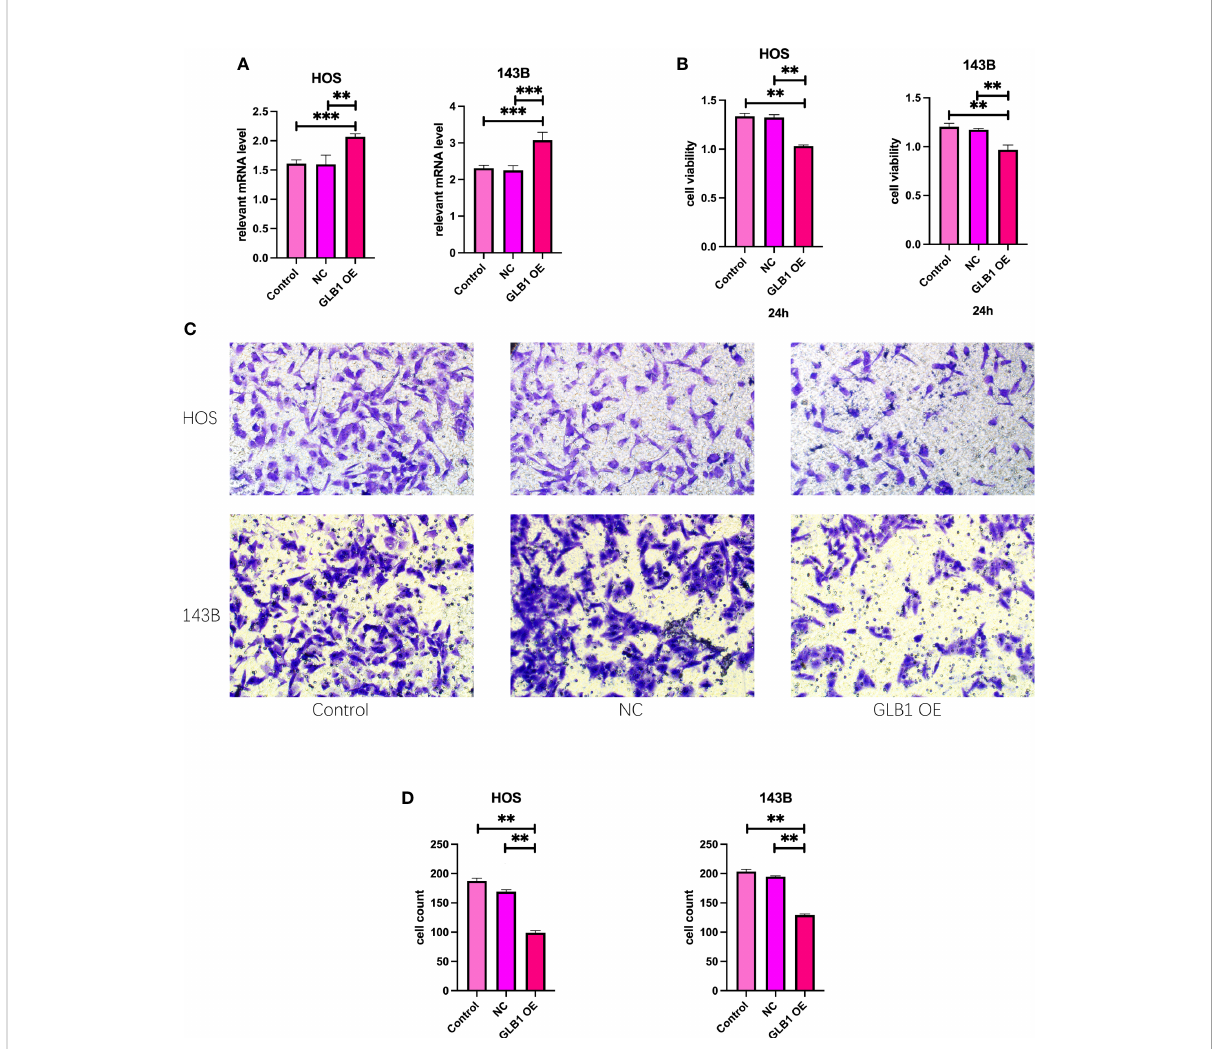
FIGURE 14 Overexpress GLB1 inhibits the proliferation and invasion of human OS cell lines. (A) The relevant mRNA lever of GLB1. In both the HOS and 143B cell lines, the GLB1 expression plasmids were transfected successfully. (B) The cell viability measured by CCK-8 assay indicates that overexpression of GLB1 inhibits the proliferation of human OS cell lines (HOS, 143B). (C, D) The photograph and the statistical analysis results of transwell invasion assay, which shows the overexpression of GLB1 inhibits the invasion of human OS cell lines (HOS, 143B). “ ** ” represented “ p<0.01 ” , “ *** ” represented “ p<0.001 ”